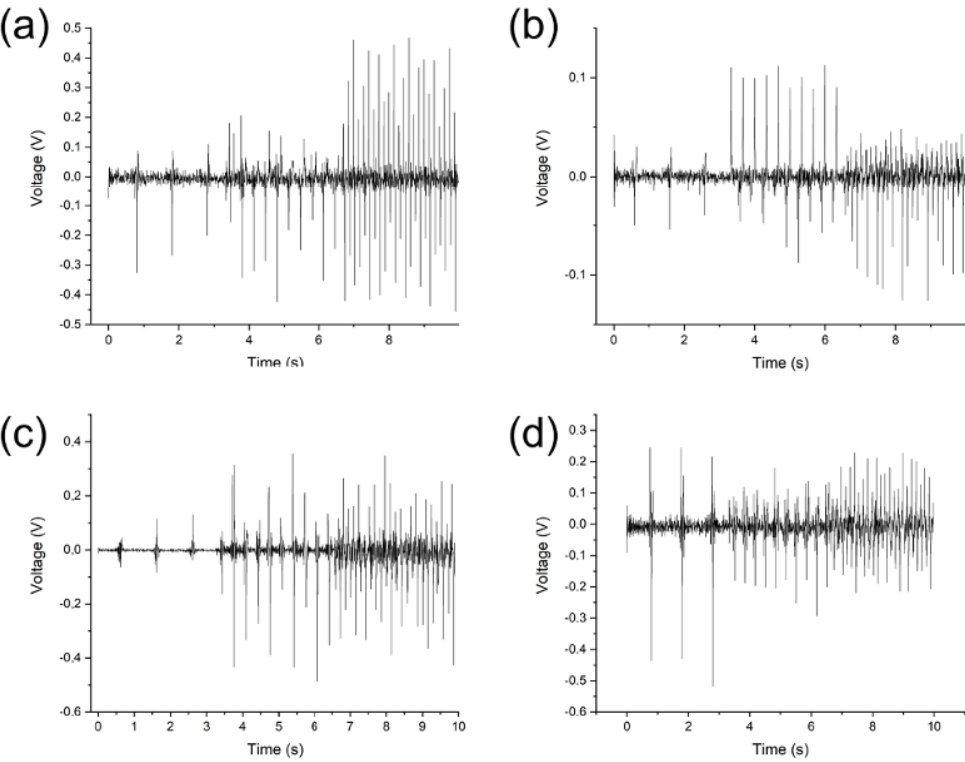
Figure 4. The piezoelectric response registered at various excitation frequencies for different samples of the SbSI/PU nanocomposite: 1 mm thick non-poled ( a ) and poled ( b ) samples; 2 mm thick non-poled ( c ) and poled ( d ) samples.